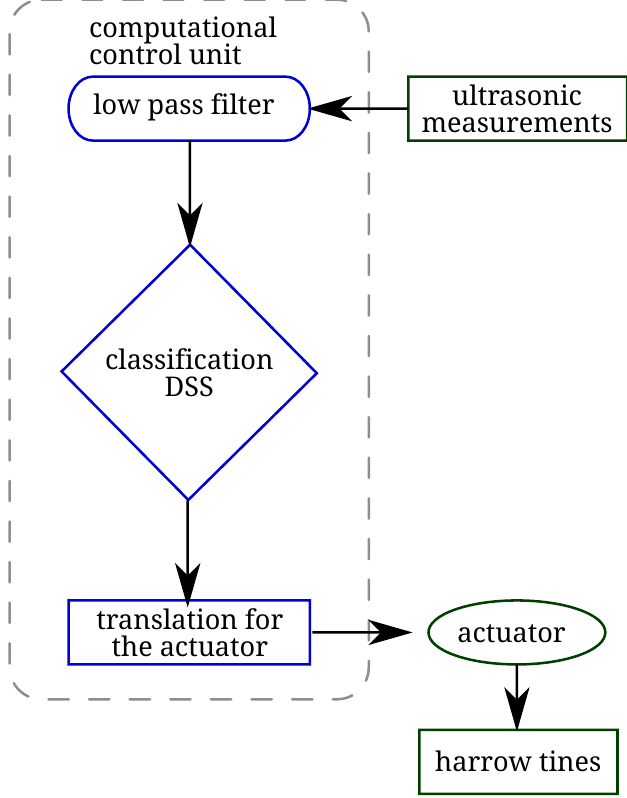
Figure 2. Flow chart of the various elements which composed the complete experimental setup, from measurement to the final adjustment of the application